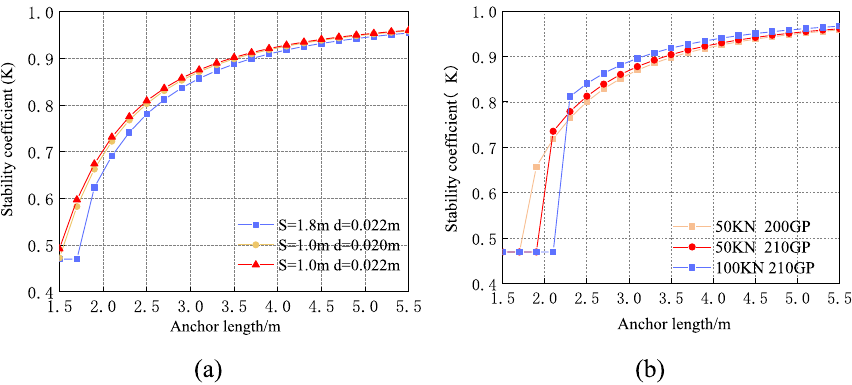
Figure 14. Effect of different values of anchor rod length, spacing, diameter, elastic modulus, and pretension force on stability of surrounding rock reinforcement body: ( a ) Different values of anchor length, diameter, and spacing; ( b ) Different values of anchor length, pretension force, and elastic